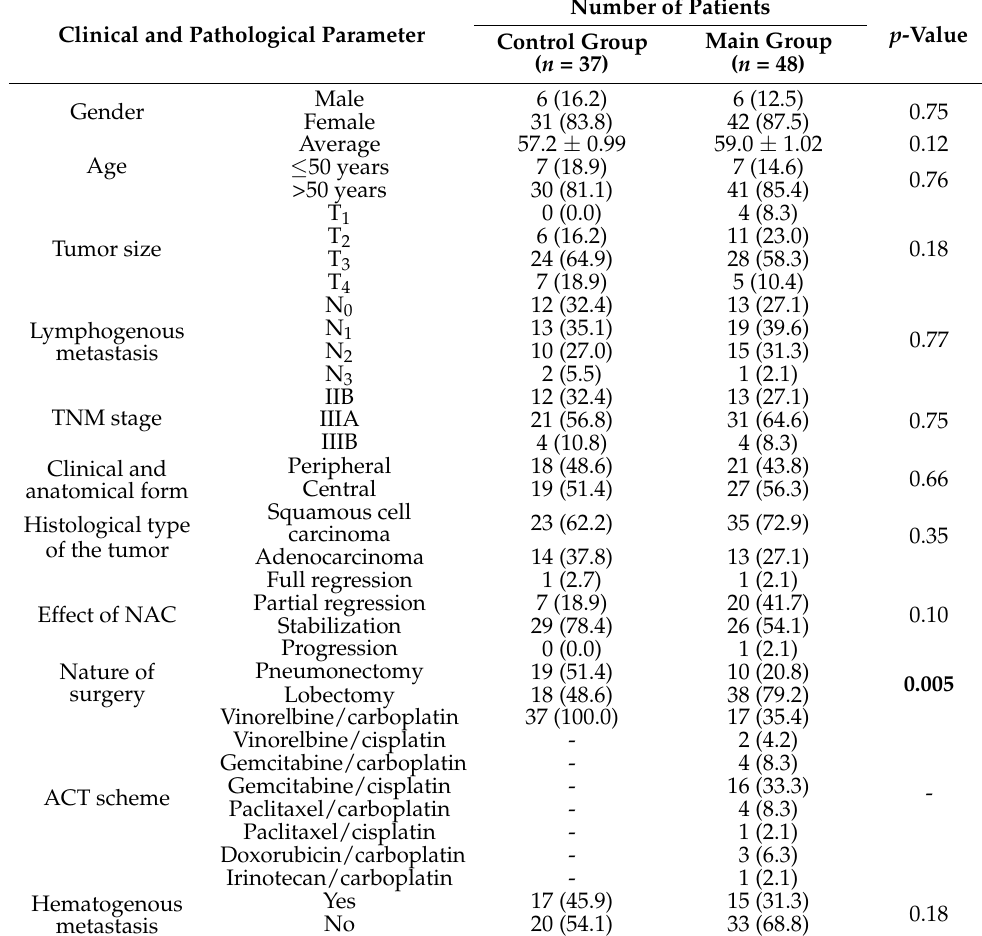
Table 2. Clinical and pathological characteristics of non-small-cell lung cancer